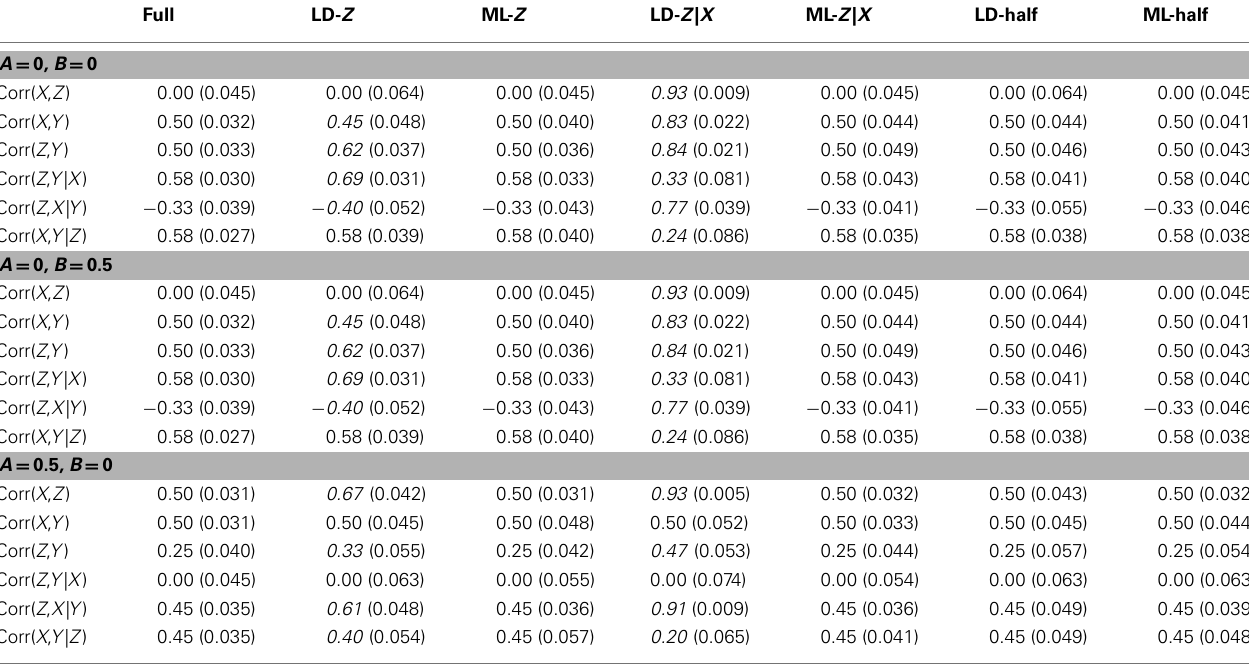
Table 3 | Estimates and their SD for correlations and partial correlations across various null situations ( N =